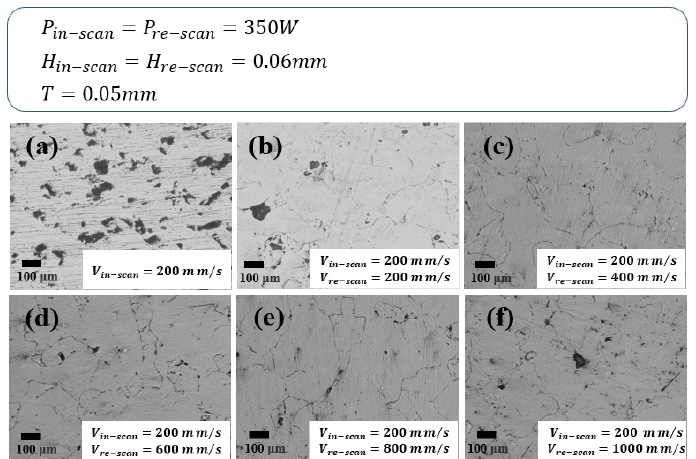
Figure 7. Micrographs of polished surfaces under SMS ( a ) and RMS ( b – f ).